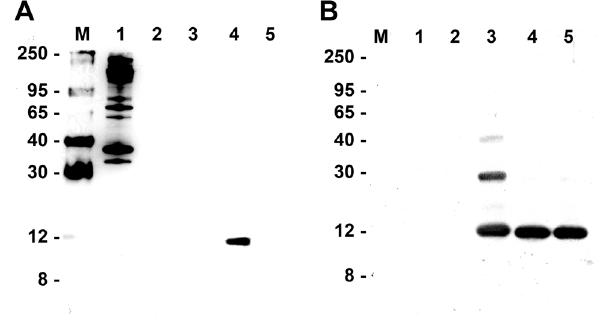
Figure 3. Insulin treatment leads to phosphorylation of brain cytochrome c . Ischemic pig brain tissue was treated + / 2 insulin following Cyt c purification under conditions that preserve protein phosphorylation. (A) Western analysis with an anti-phosphotyrosine antibody (4G10) indicates tyrosine phosphorylation of Cyt c after insulin treatment (lane 4), whereas Cyt c isolated without insulin treatment (lane 5) or obtained from a commercial source (lane 3, Sigma Cyt c ) does not produce any signal. Lane M, protein size marker (kDa); lane 1, EGF stimulated A431 cell lysate (positive control for Western analysis); lane 2, ovalbumin (negative control for Western analysis). Western analysis with anti-phosphoserine and anti-phosphothreonine antibodies did not show any signal (not shown). (B) Control Western blot with an anti-Cyt c antibody shows similar loading. Samples in lanes 1–5 as denoted in A. Note that additional bands in Sigma Cyt c correspond to the Cyt c dimer and trimer that are sometimes observed depending on the batch.